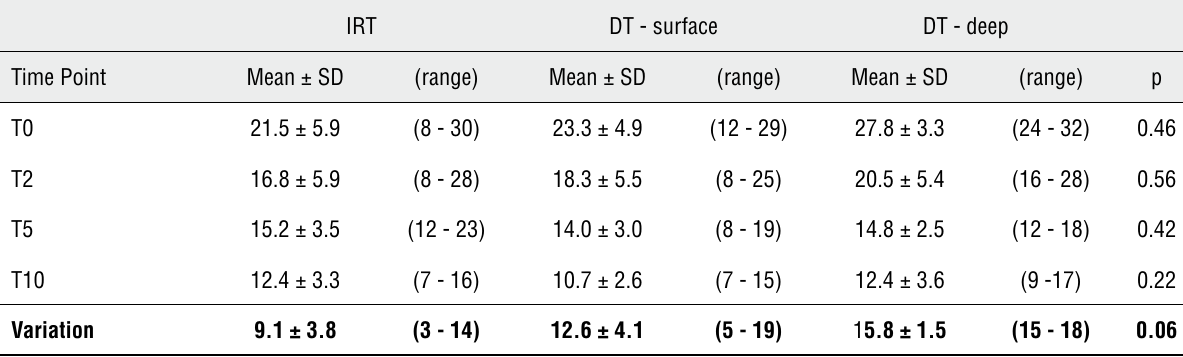
Table 1 - Comparative analysis of temperature decrease during cold renal ischemia procedure.